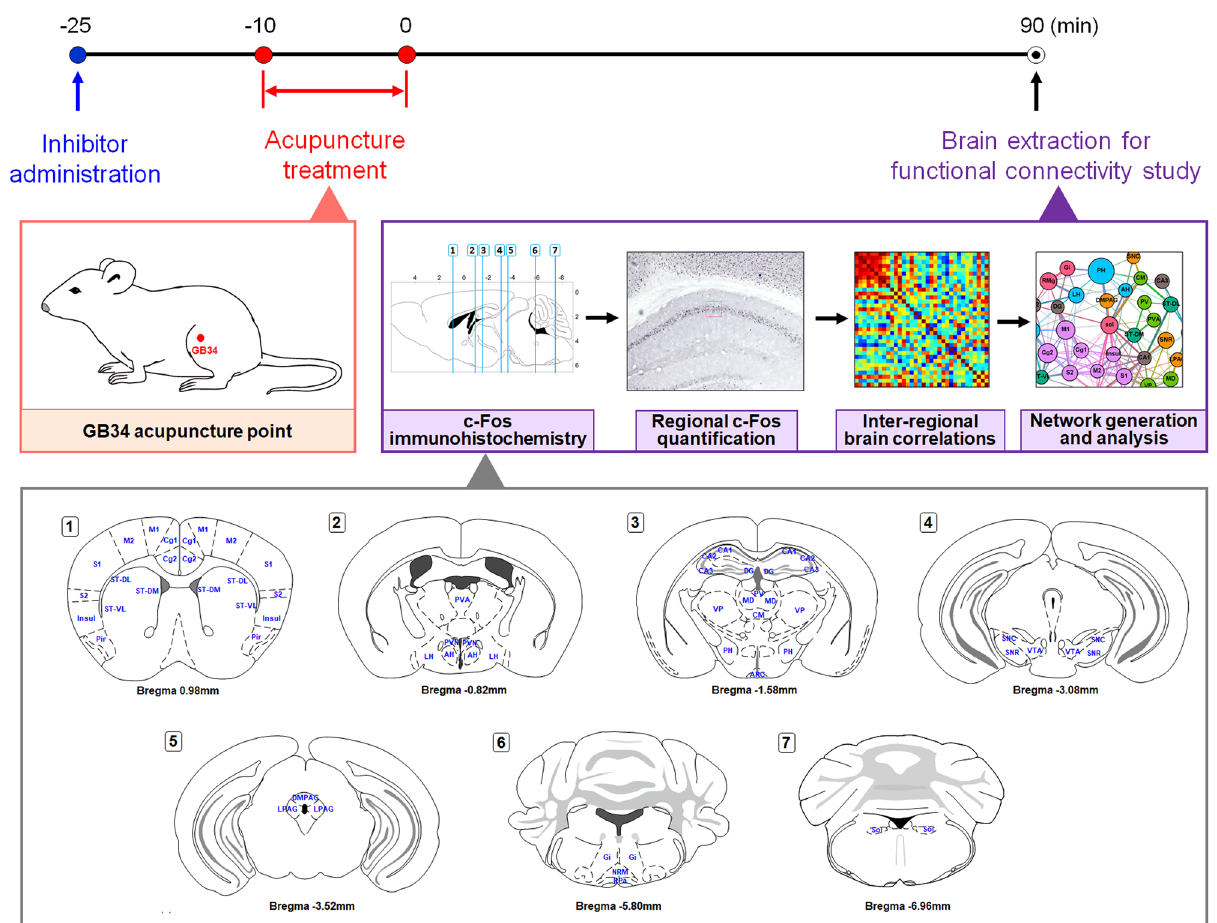
Figure 2. Schematic diagram of experimental schedule for functional connectivity study. Acupuncture was performed at bilateral GB34 (Yangneungcheon, Yanglingquan) for 10 min and inhibitor was administrated 15 min before acupuncture treatment. The brains were removed 90 min after acupuncture treatment for identifying the brain neural responses and the brain functional connectivity. The c-Fos positive cells were quantified in each of the 34 brain regions, and a set of inter-regional correlations were computed. Finally, functional networks were generated. Abbreviations for each brain region are shown in Table